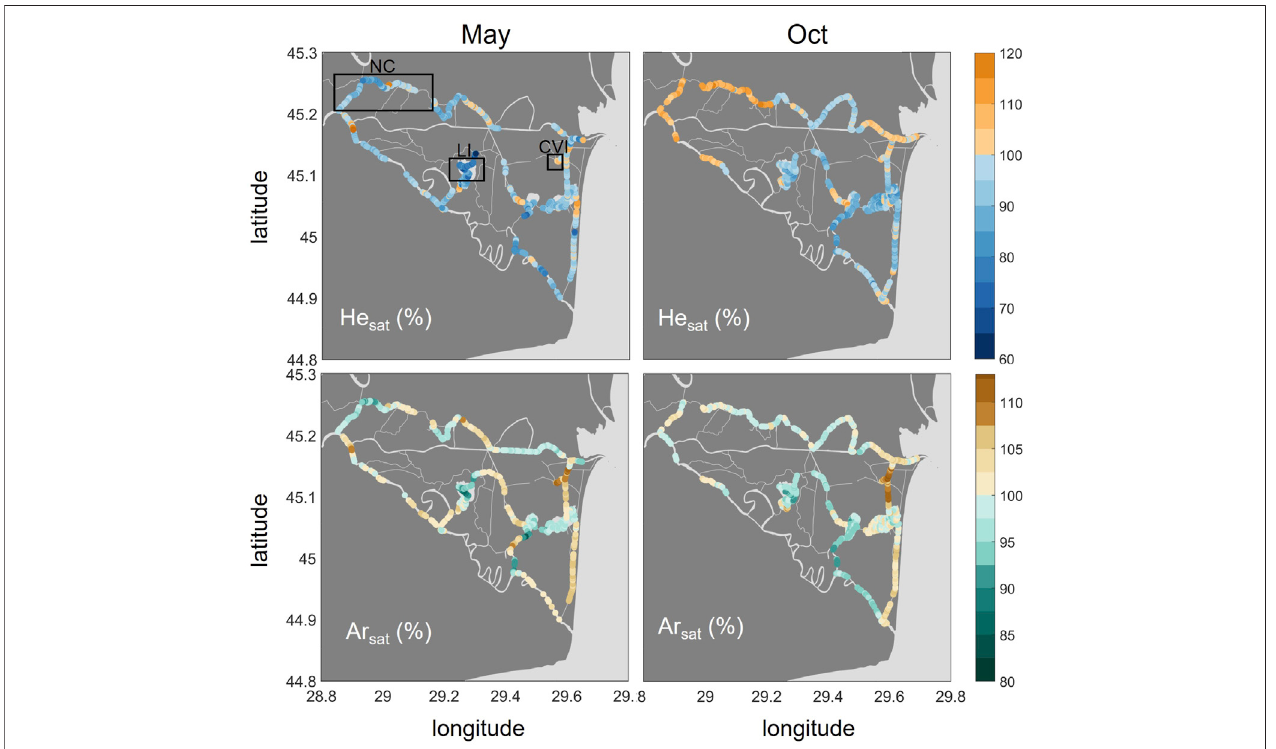
FIGURE 4 | Spatial distribution of He (top row) and Ar (bottom row) in % saturation in May and October 2017. Oversaturation is shown in orange/brown and undersaturation in blue/turquoise. Please note the different ranges of the color bars. The boxes in the upper left graph indicate the locations of the Northern Channels (NC), Lake Isac (LI) and Canal Vatafu-Imputita